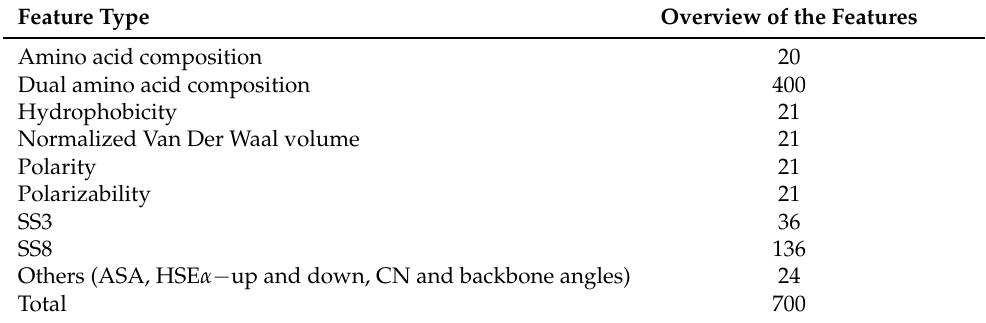
Table 2. Feature